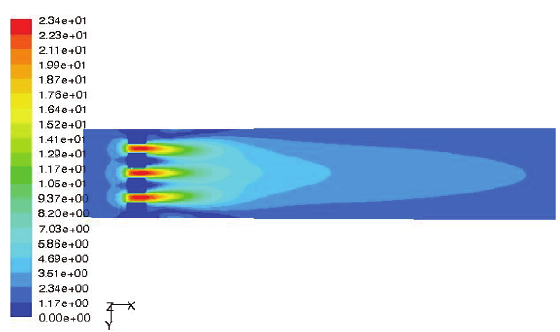
Figure 9. Velocity field through isosurfaces: 3 × 3 in-corridor jets with square shape, zoom section Z = 0.